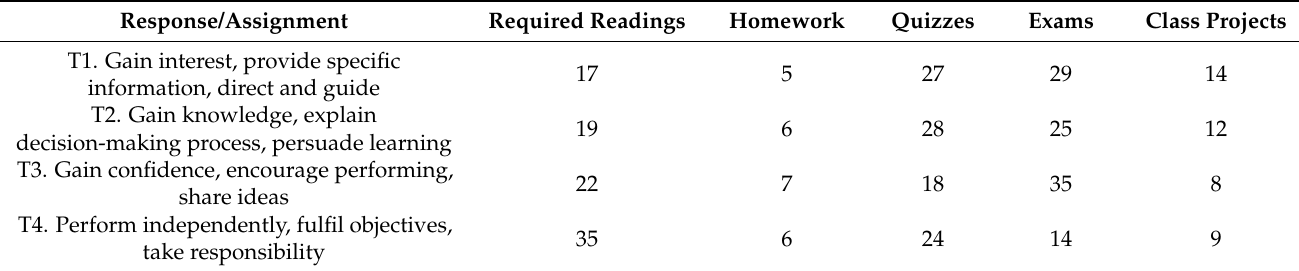
Table 8. Average percentage of responses for the least helpful assignments (excluding blank, void, and other responses).